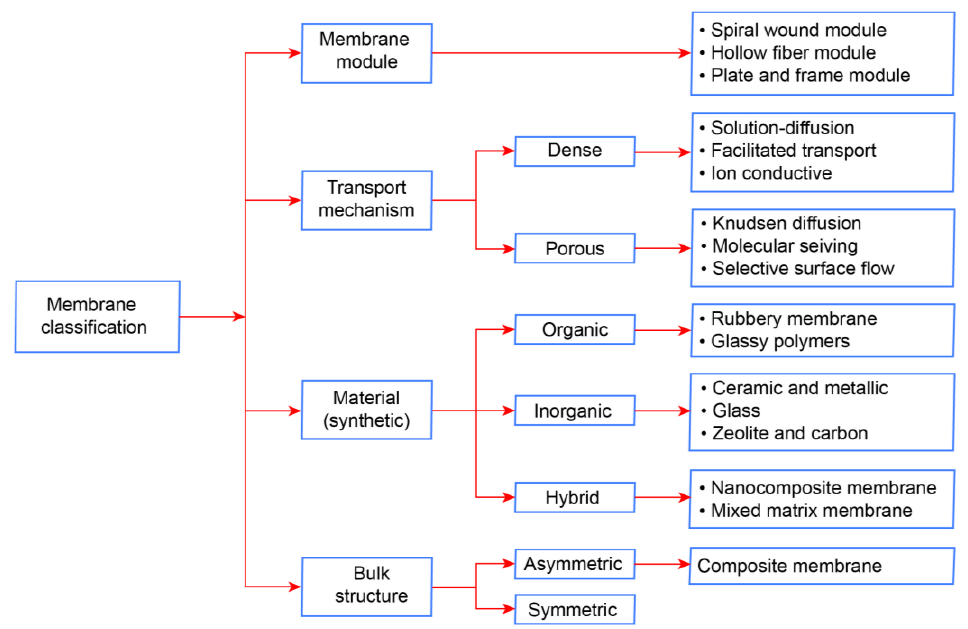
Figure 8. Different classifications and applications of membranes in post-combustion CO 2 capture (Based on [67]).